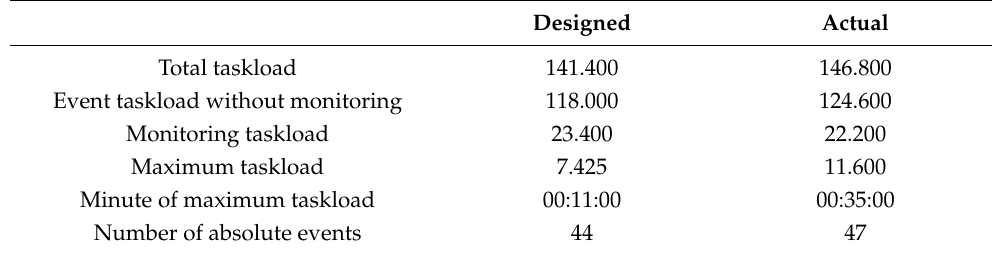
Figure 5. Combined representation of the designed taskload profile (green bars) and the actual task- load profile (blue bars) for Exercise 1 of Participant 5. Table 2. Comparison of the most relevant data that characterise the designed and actual taskload